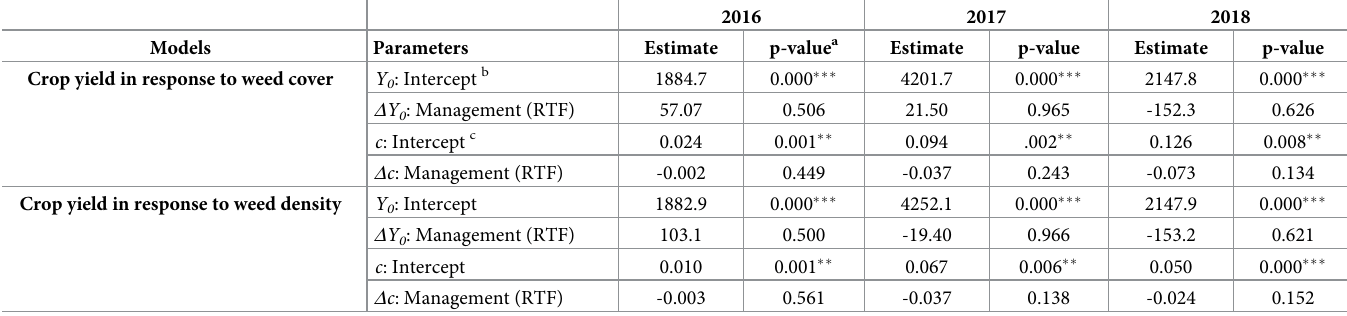
Table 5. Non-linear mixed model (NLMM) analysis to study the parameters significance of the relationship (represented by the exponential model) between crop yield and weed cover, and crop yield and weed density in the two fallow managements (summer fallow (SF) and reduced tillage fallow